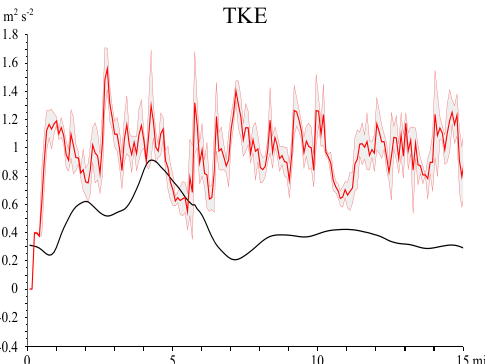
Figure 11. Five-minute time series of TKE depending on the forc- ing scale: the TKE obtained with 160m × 160m × 24m is drawn in red, and the TKE obtained with 80m × 80m × 24m is drawn in blue. The fine Meso-NH TKE is drawn in